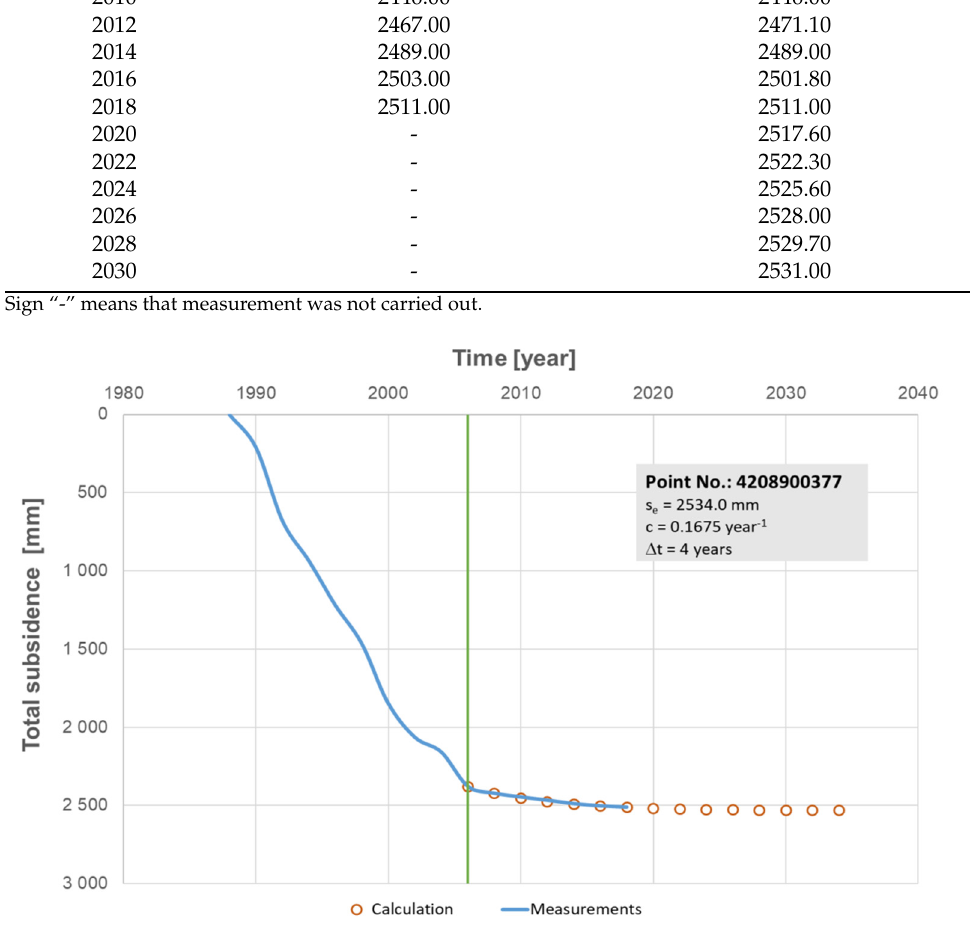
Table 6. Estimated time of subsidence for subsidence limit